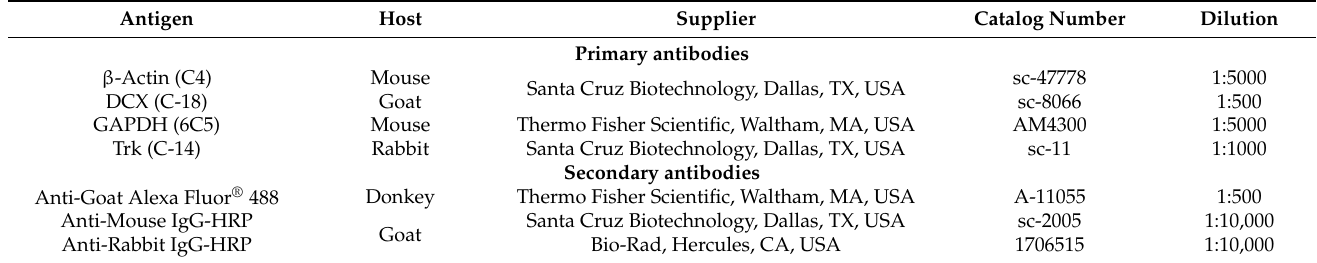
Table 1. Antibodies used for Western blot and